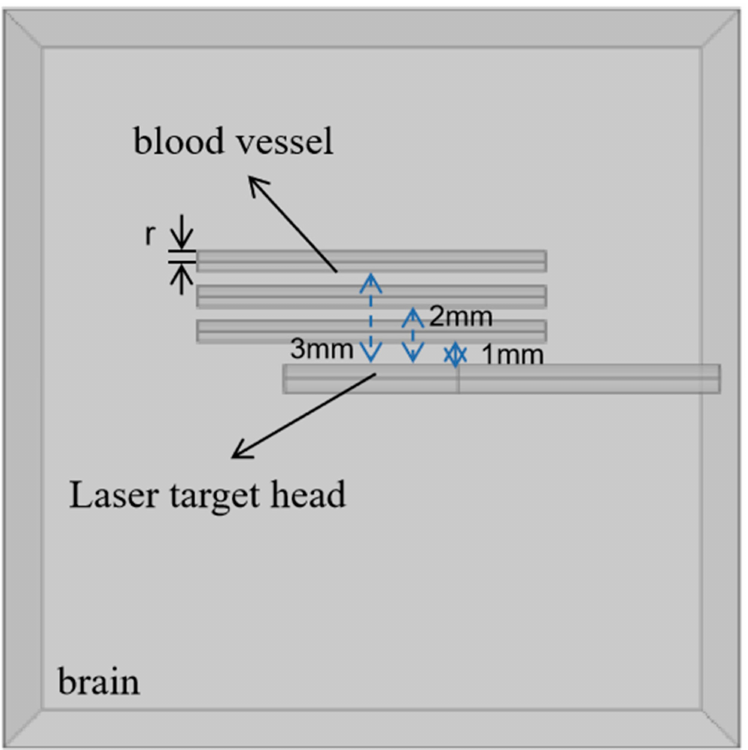
Figure 9. Model diagram of the distance between different fibers and blood